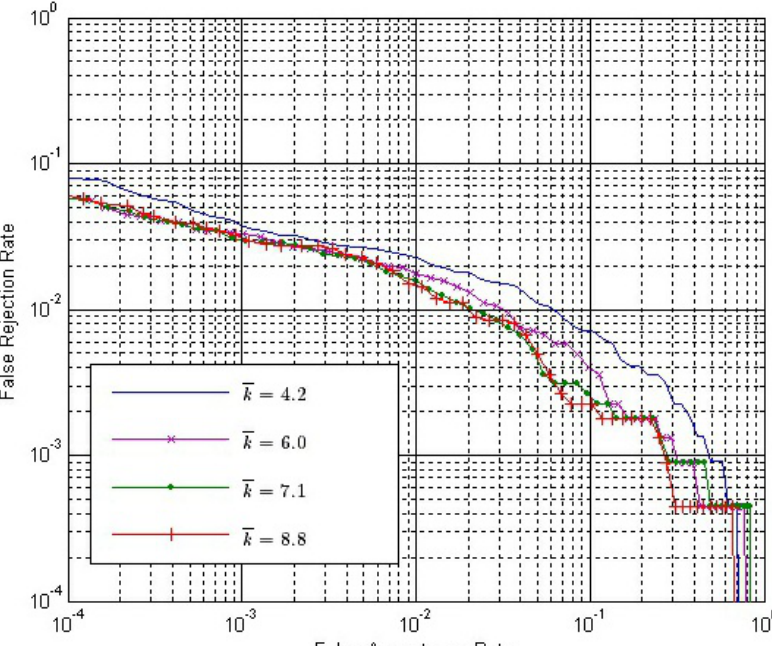
Figure 15. ROC of the final match score with different k values, where both S E and S C are calculated by Strategy IS-2 and S O is calculated by Strategy